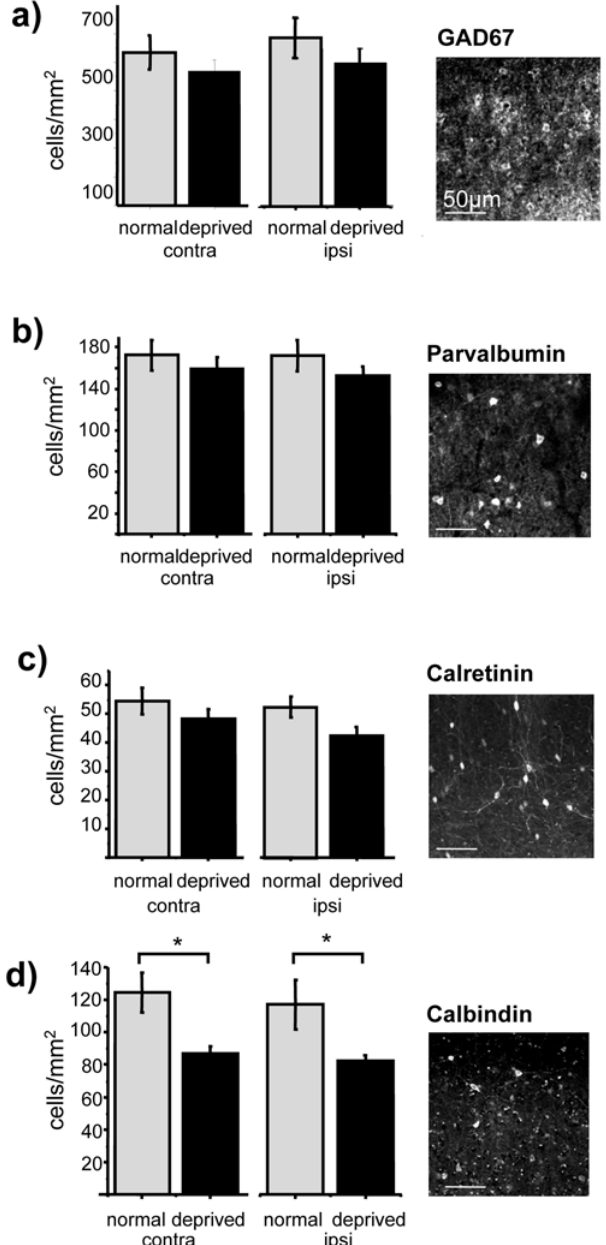
Figure 3. Effects of MD on inhibitory neuron markers. Long-term MD has no effect ( t test, p . 0.05) on the expression of GAD67 ( a ), PV ( b ) and CR ( c ), while it decreases the number of CB immunoreactive cells ( d ) in both hemispheres ( t test, contra to the deprived eye P=0.005, and ipsi P=0.019).